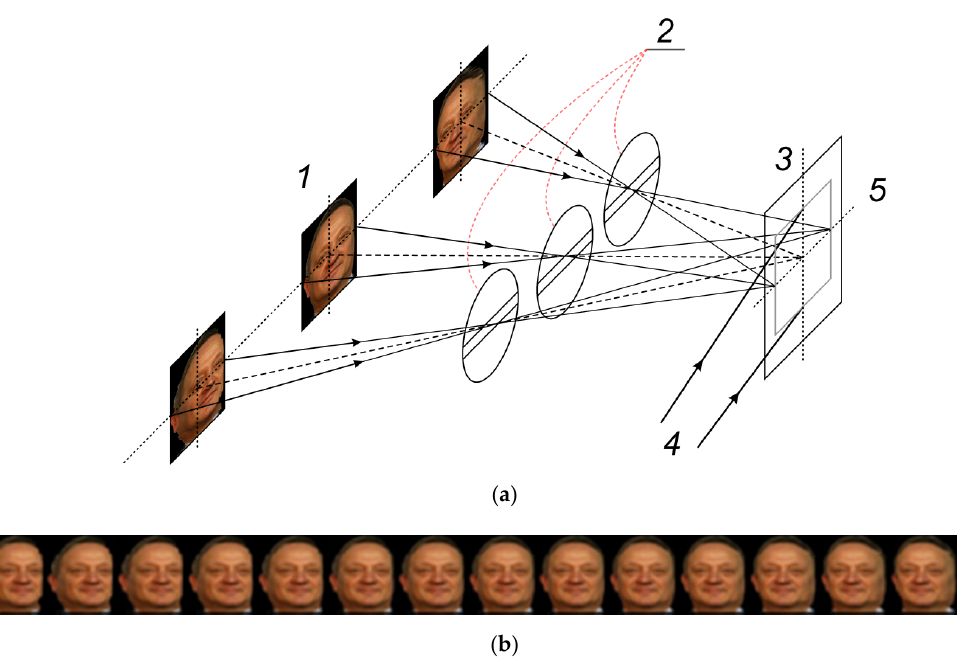
Figure 5. ( a ) A scheme for recording of the focused image holograms from different directions, with slit-filter filtering; ( b ) compilation of 15 angles of the 3D object image.